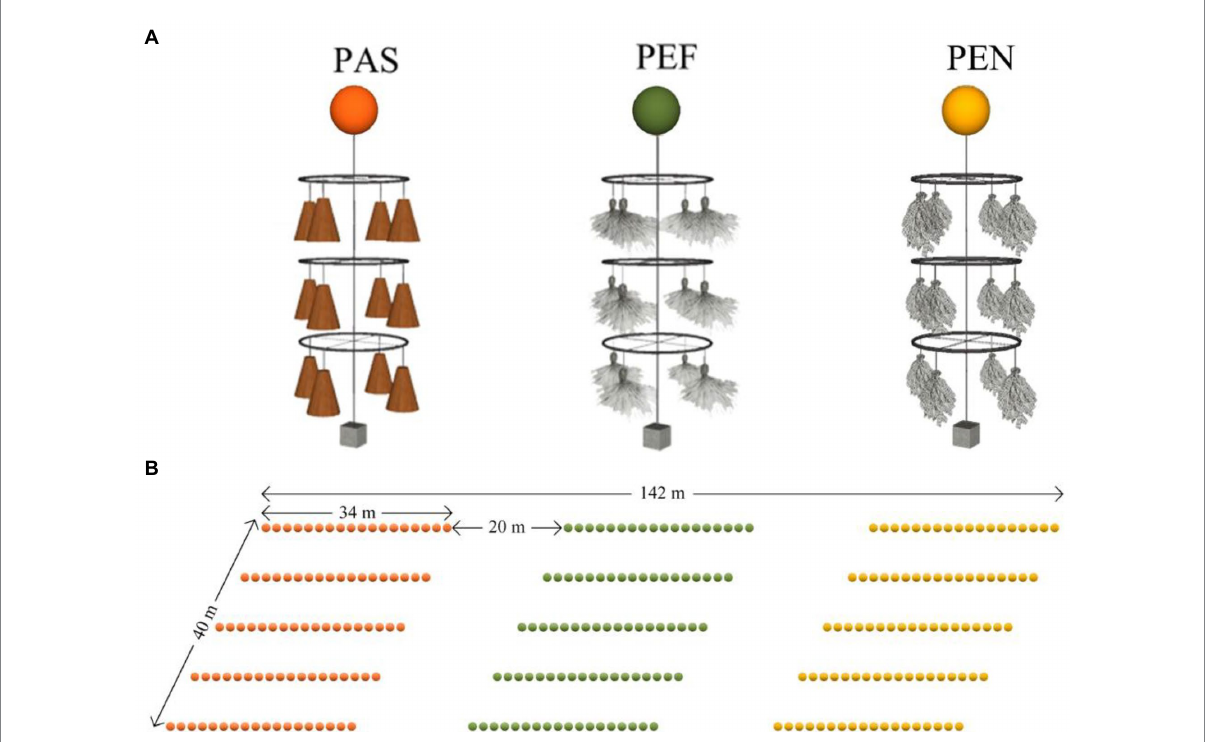
FIGURE 2 The structure of artificial spawning substrates (A) and arrangement of artificial spawning grounds (B) . PAS, palm sheet; PEF, polyethylene filament; PEN, polyethylene